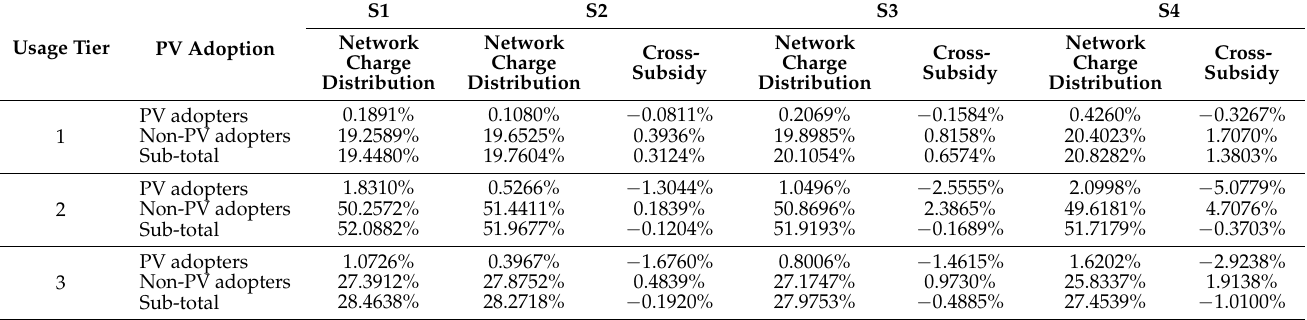
Table 5. Network charge distribution by PV penetration, usage tier and PV adoption.